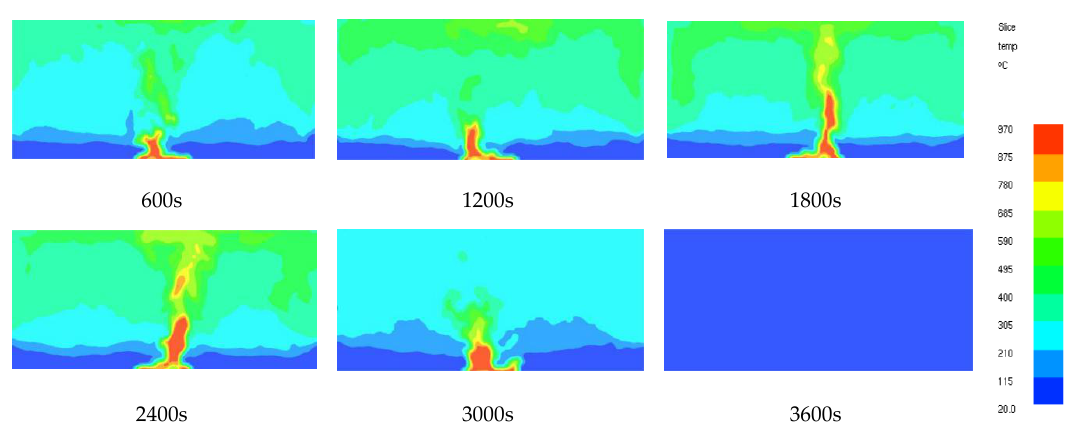
Figure 8. Slice temperature cloud (fire source location I).